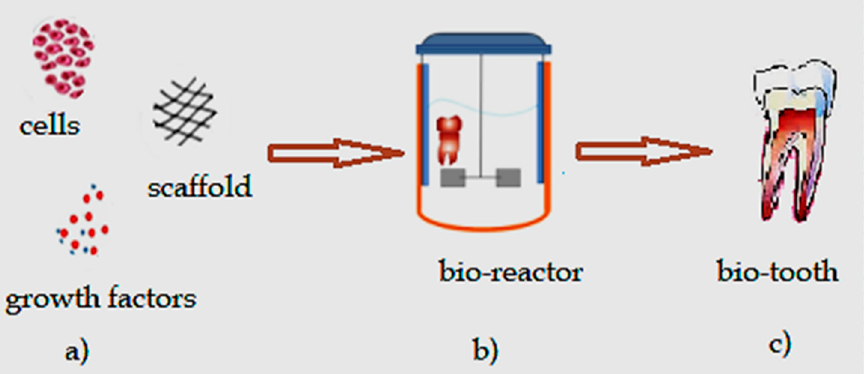
Figure 5. Bio-engineered tooth: ( a ) selection of dental cells sources and scaffolds, with addition of growth factors, ( b ) bio-reactor for in vitro development of bio-engineered tooth bud, ( c ) bio-tooth.